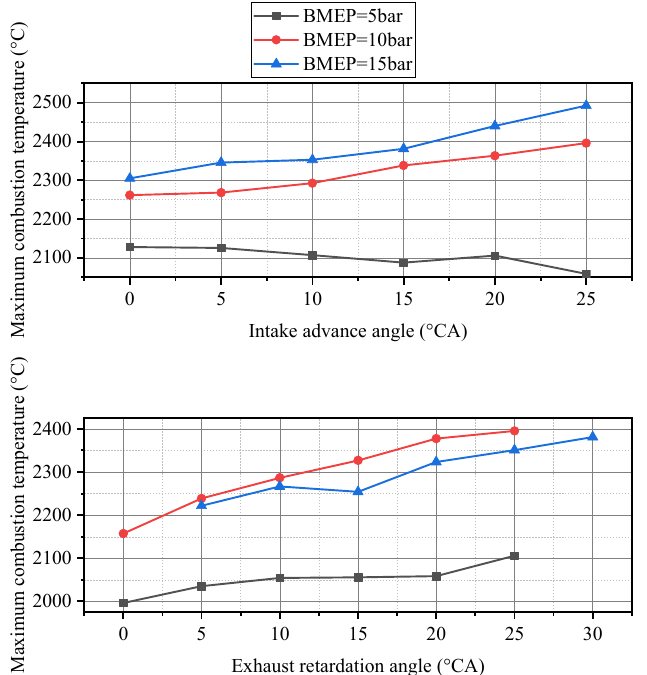
Figure 9. Maximum combustion temperature versus intake advance angle under baseline EVC, and maximum combustion temperature versus exhaust retardation angle under the Miller cycle at different points of operation during the test.